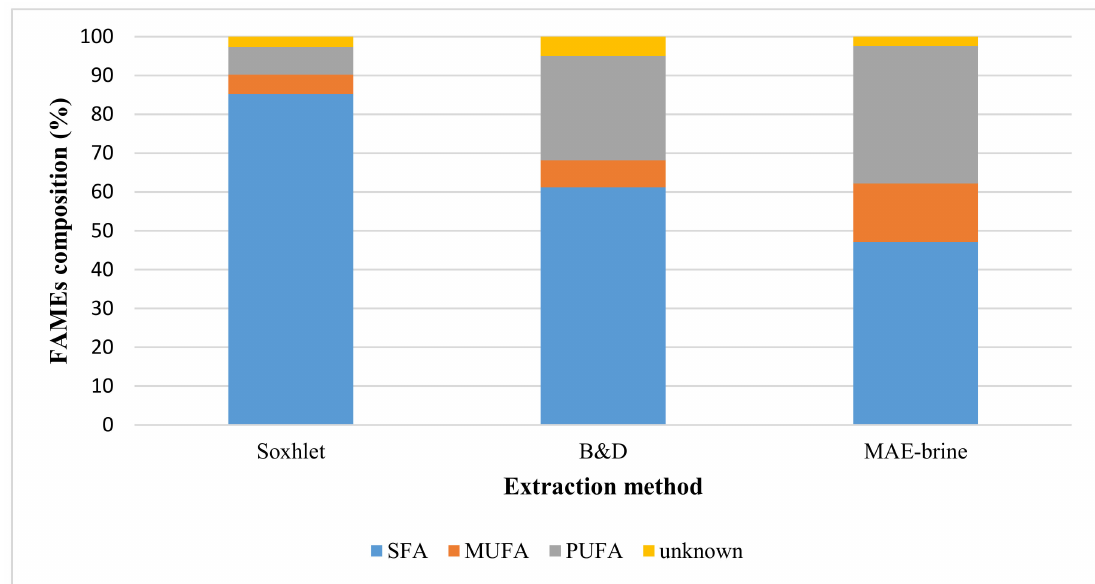
Figure 4. The distribution analysis of FAMEs classes for Nannochloropsis sp . microalgae for three extraction methods of Soxhlet, B&D and MAE-brine technique at extraction parameters of 10% ( w / v ) solid loading, 100 ◦ C and 5